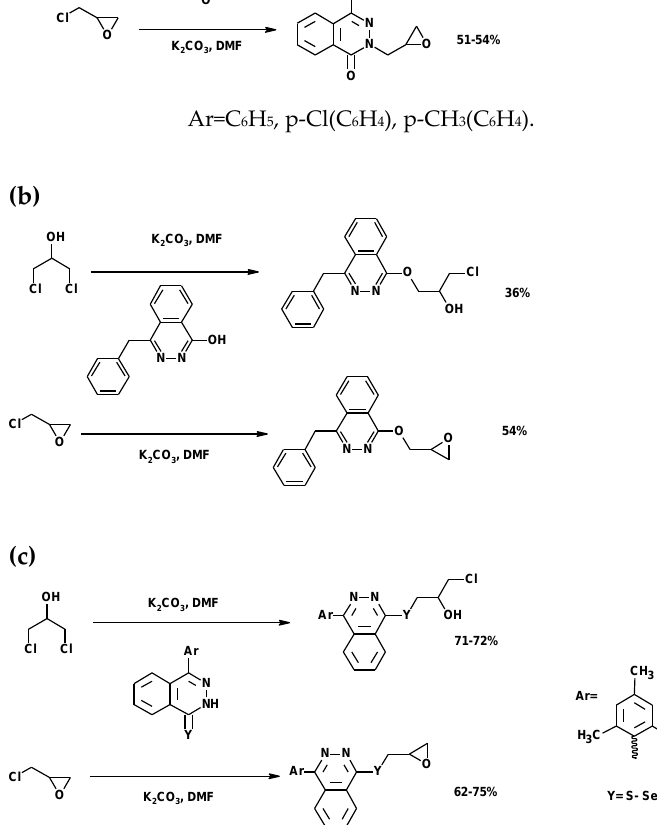
Figure18. ( a )Synthesisof N -alkylatedphtalazines[142]; ( b )synthesisof1-oxoalkylatedphtalazine[144]; Figure 18. ( a ) Synthesis of N -alkylated phtalazines [142]; ( b ) synthesis of 1-oxo alkylated phtalazine ( c ) synthesis of Se- and S -alkyl phthalazines derivatives [144]; ( c ) synthesis of Se- and S -alkyl phthalazines derivatives [143].